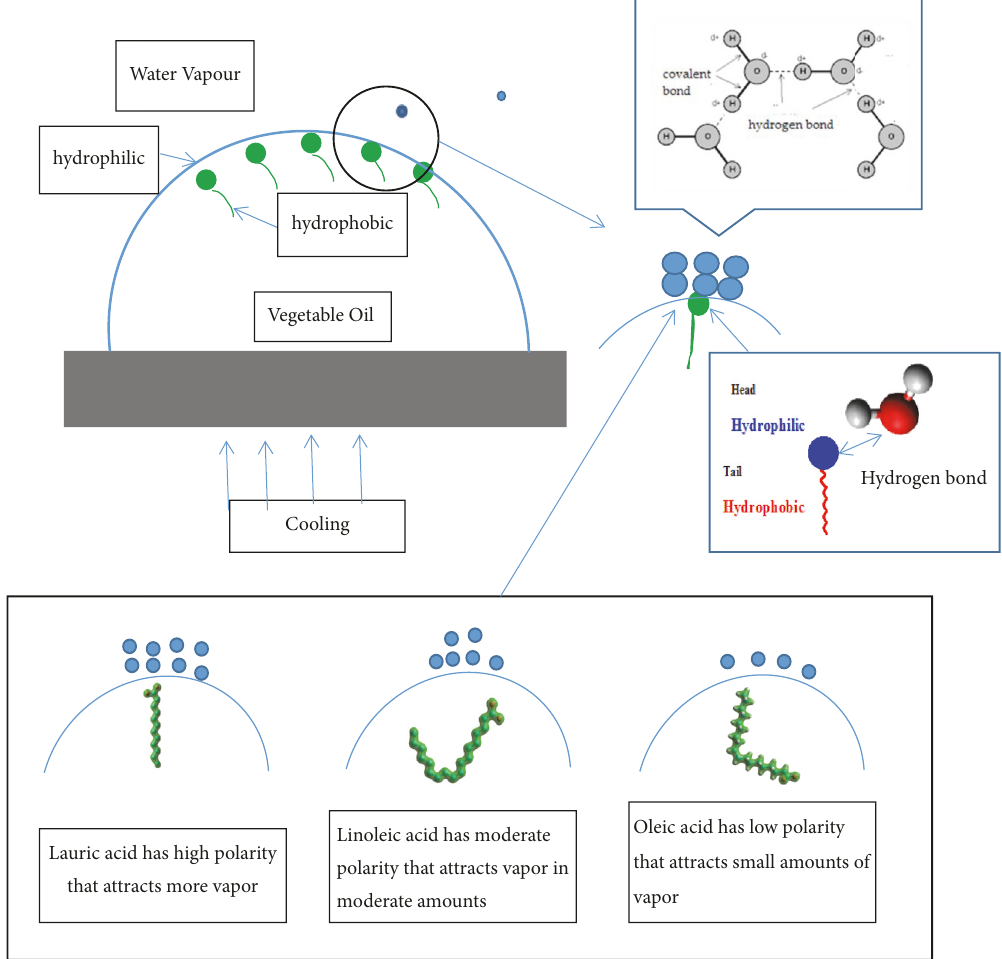
Figure 10: Intermolecular forces for moisture attraction on vegetable oil droplet surfaces.